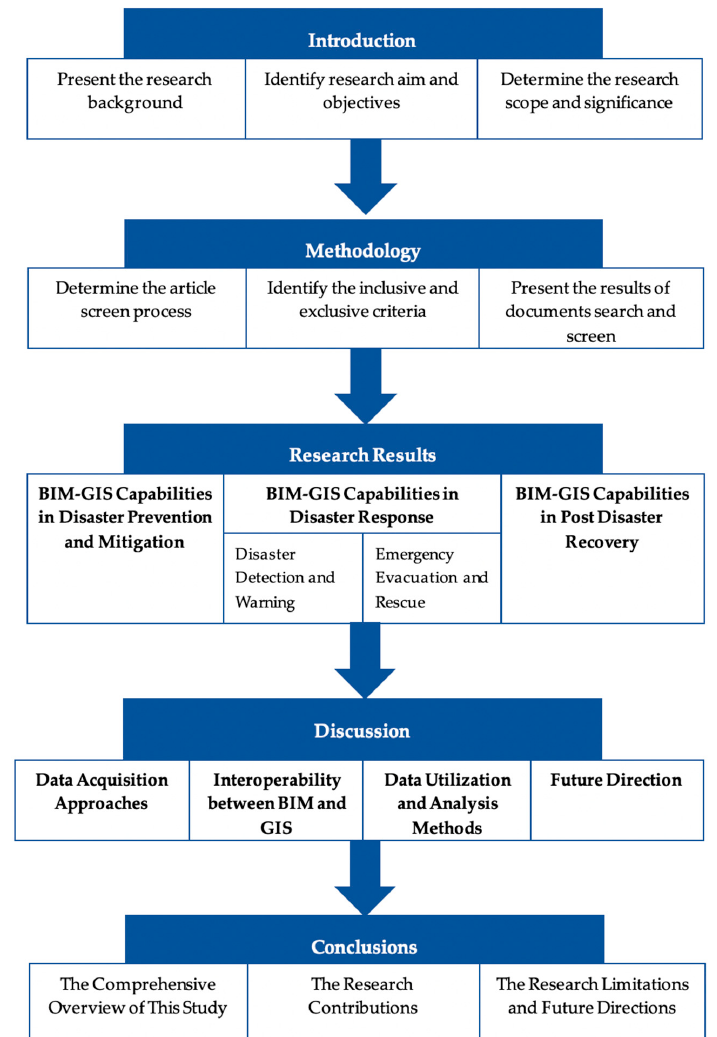
Figure 1. The Research Framework of This Study.